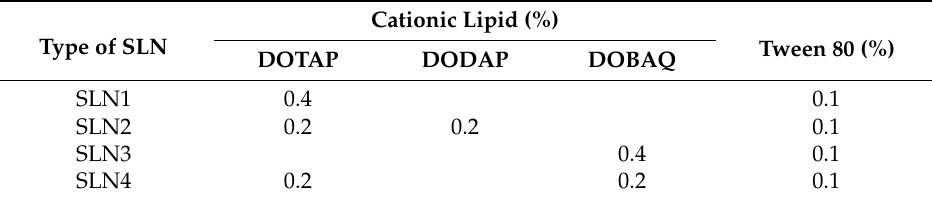
Table 3. Composition of SLNs.